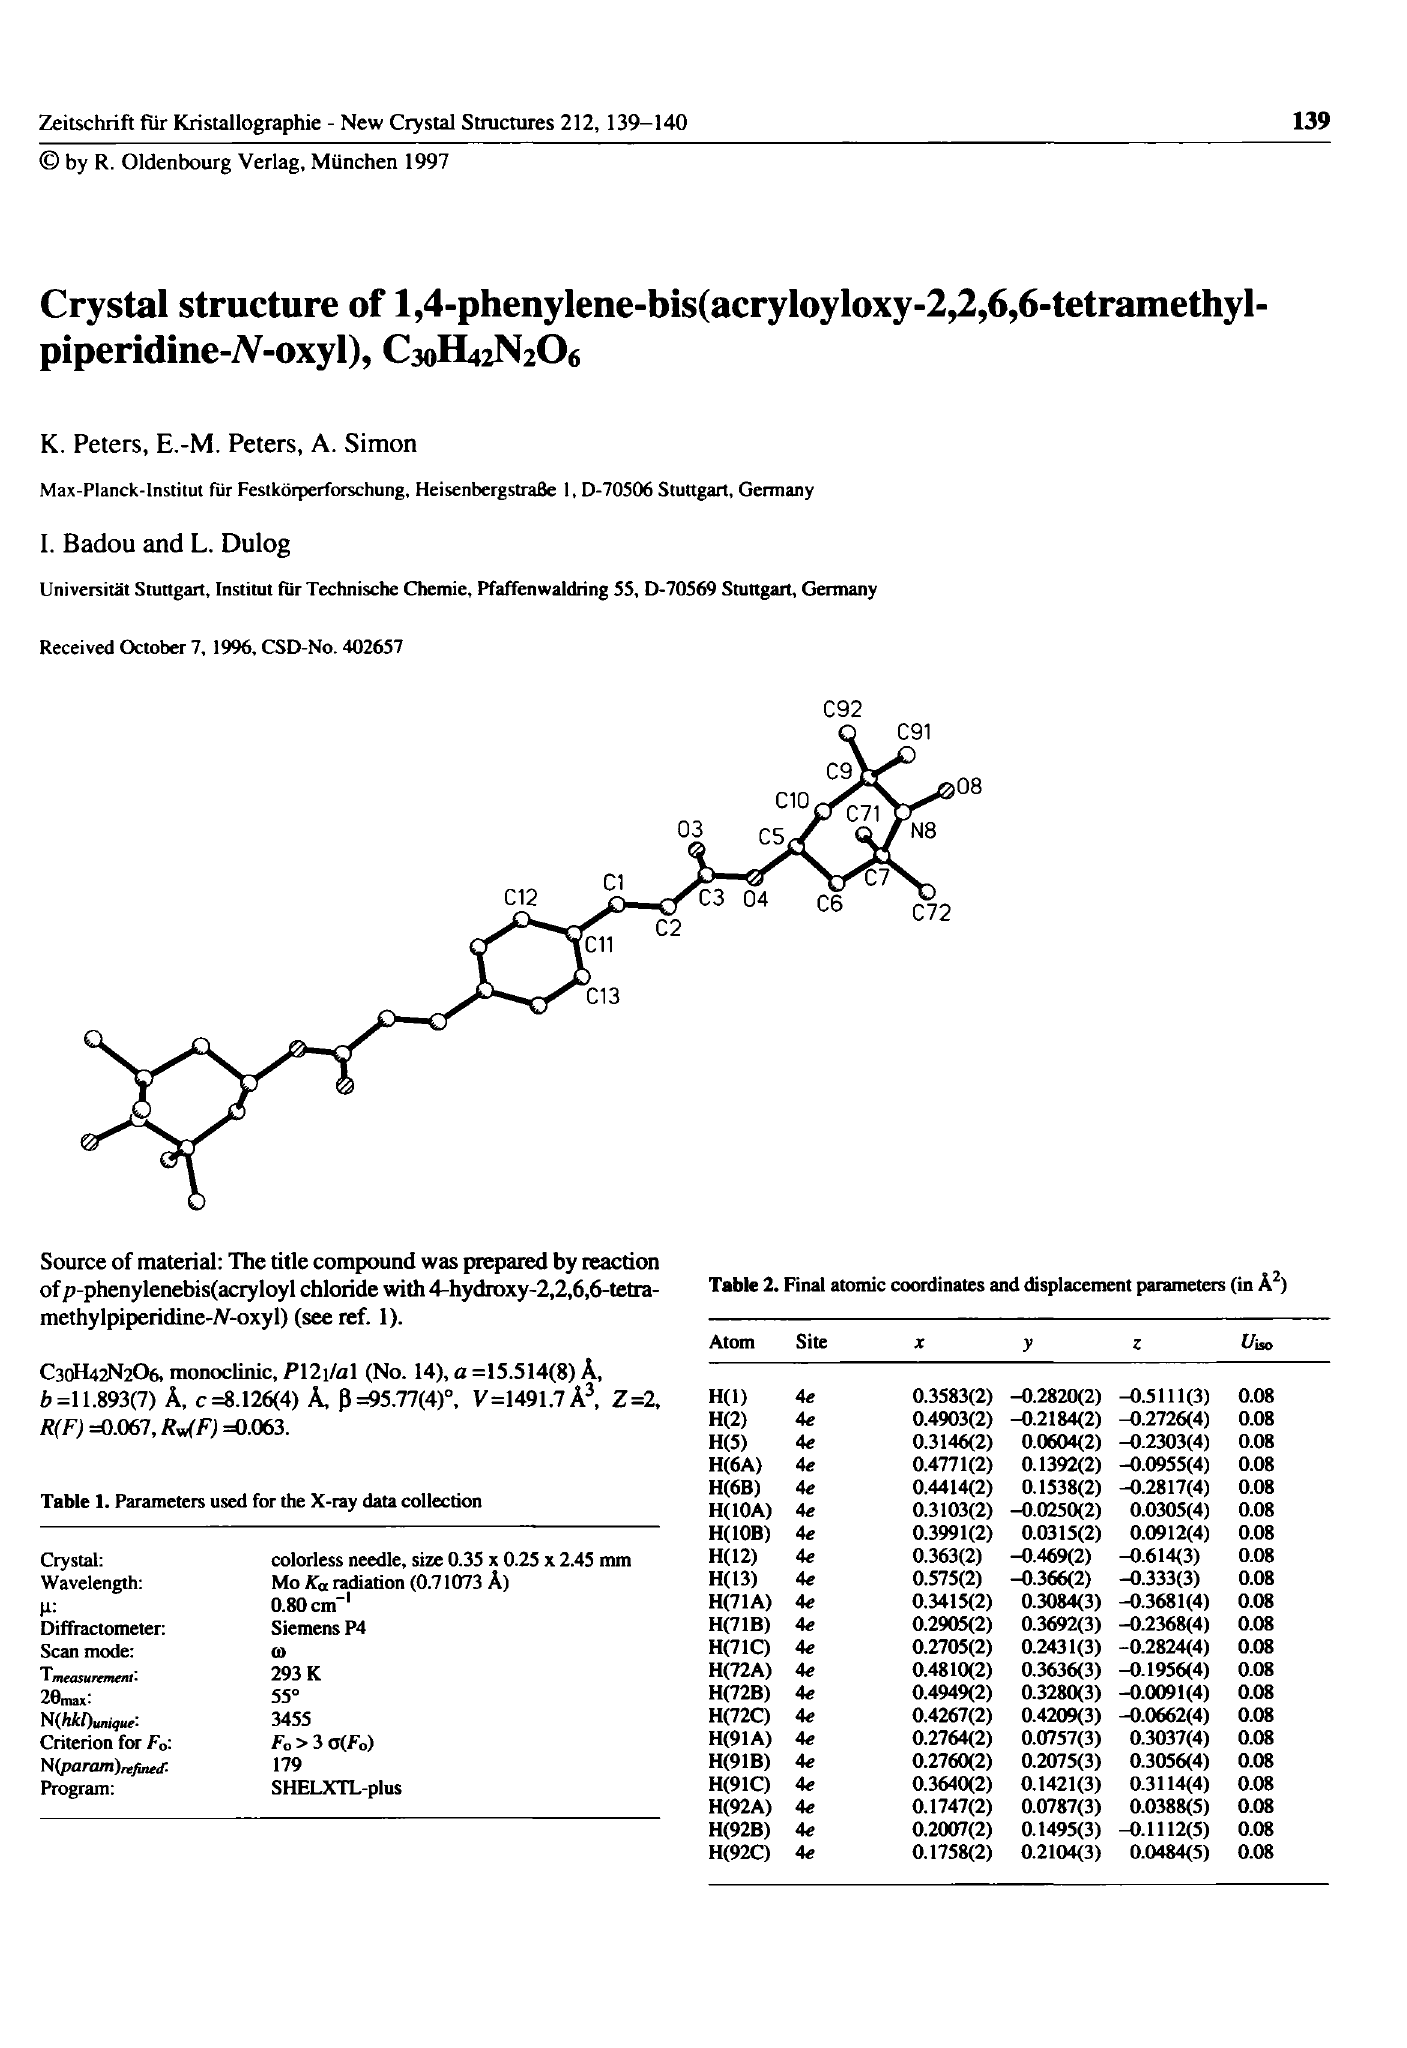
Table 1. Parameters used for the X-ray data collection